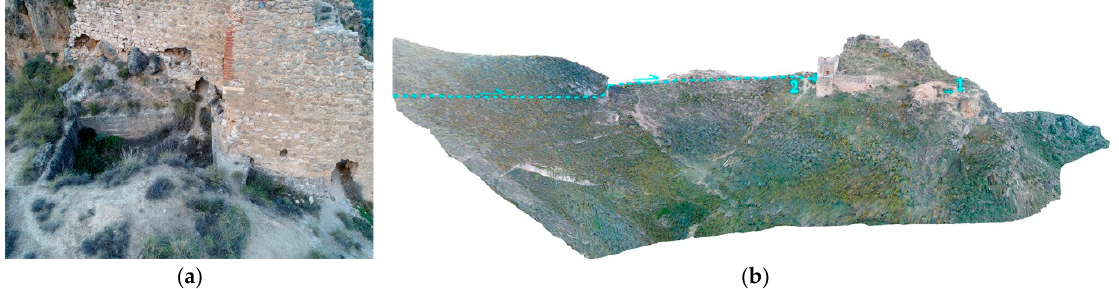
Figure 7. Fortress of Mondújar ( a ) View of the aljibe outside the walls. ( b ) Hypothesis on the water supply with cistern inside (1) and outside (2) the fortress and its blocked off arch. Created by authors.